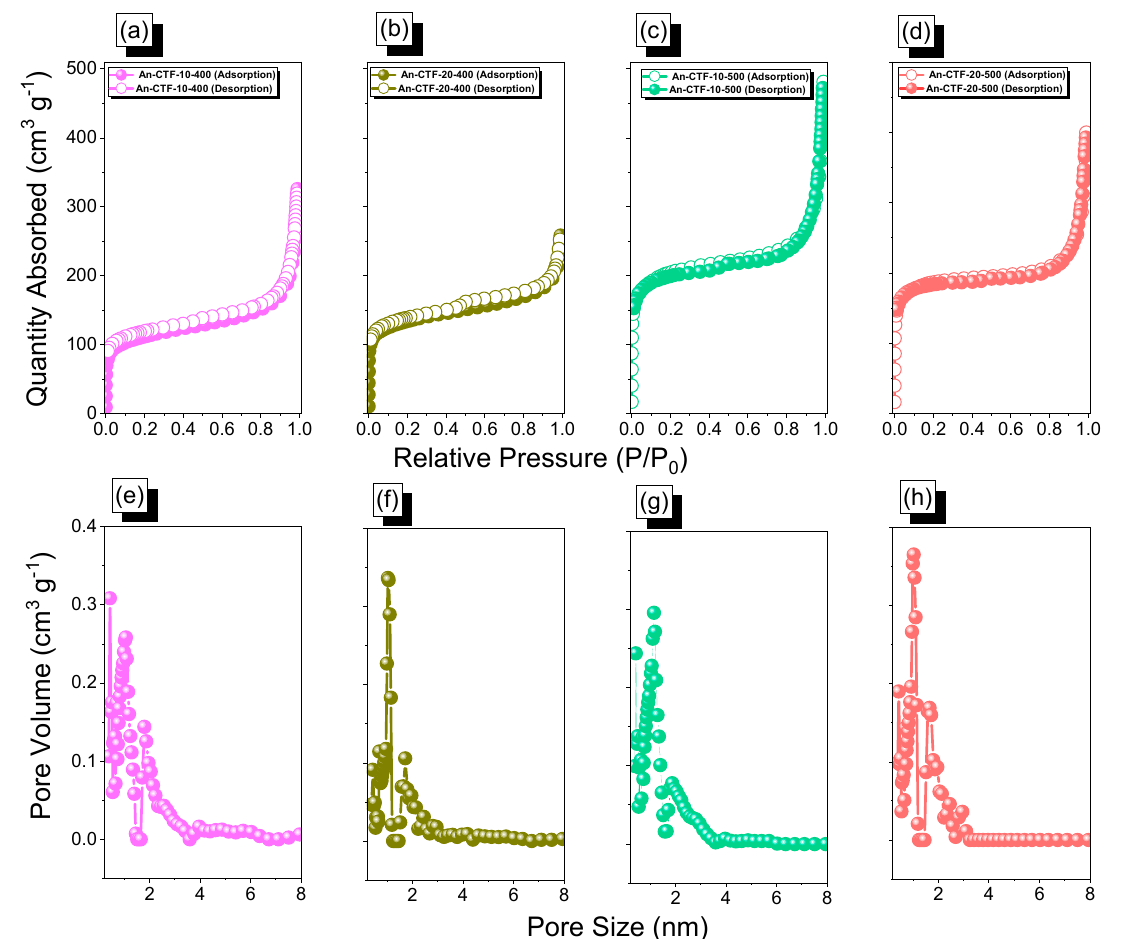
Figure 4. BET and pore diameters curves of An-CTF-10-400 ( a , e ), An-CTF-20-400 ( b , f ), An-CTF-10-500 ( c , g ), and An-CTF-20-500 ( d , h ).